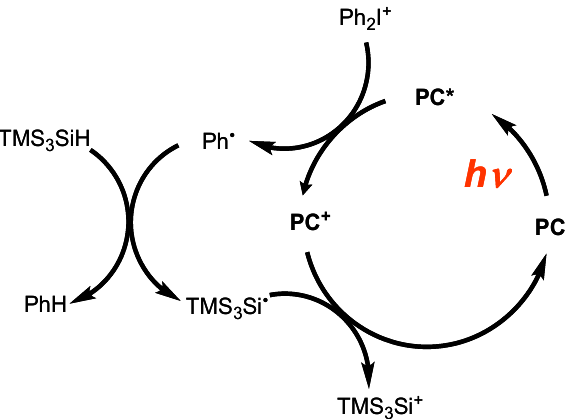
Figure 4. Polymerization profiles of (3,4-epoxycyclohexane)methyl 3,4-epoxycyclohexyl- carboxylate (Uvacure 1500 from Cytec) under air in the presence of (a) Ir(ppy) H/Ph I + (0.2%/3%/2% w/w) upon a blue LED bulb; (b) Ru(phen) 2 (0.2%/3%/2% w/w) upon a white LED bulb